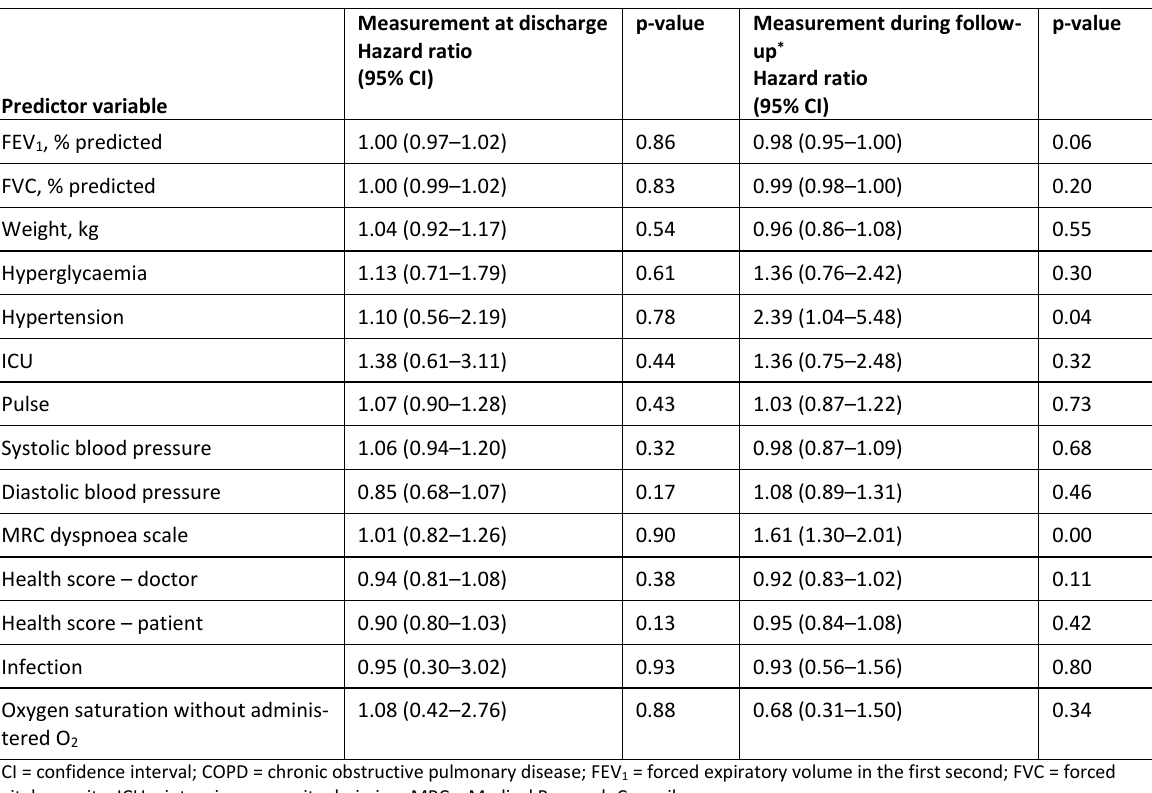
Table 5: Hazard ratios of re-exacerbation associated with the p-values of predictor variables at discharge and during follow-